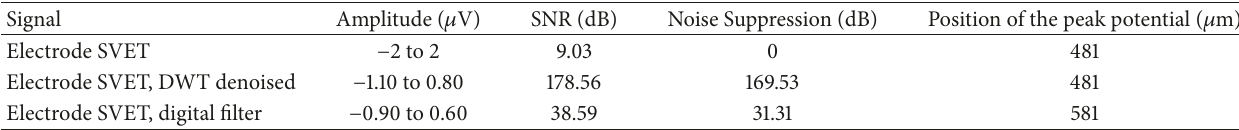
Table 1: Results of measurement and noise attenuation with wavelet transform and digital